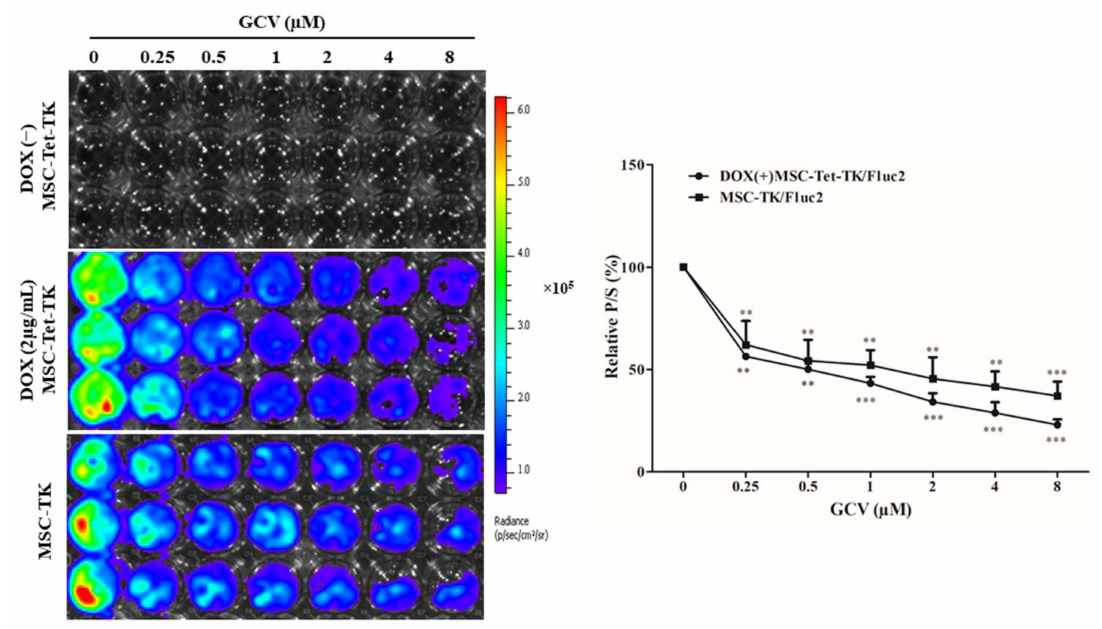
Figure 2. Fluc activity of MSC-Tet-TK and MSC-TK cells after ganciclovir (GCV) treatment for 48 h. Fluc activity was measured by bioluminescent imaging (BLI) imaging, and the quantitation for MSC-Tet-TK and MSC-TK cells is shown in the right hand panel. Values obtained from three individual experiment are expressed as the mean ± standard deviation (SD), ** p < 0.01, *** p < 0.001 (by Student’s t test). p/s,